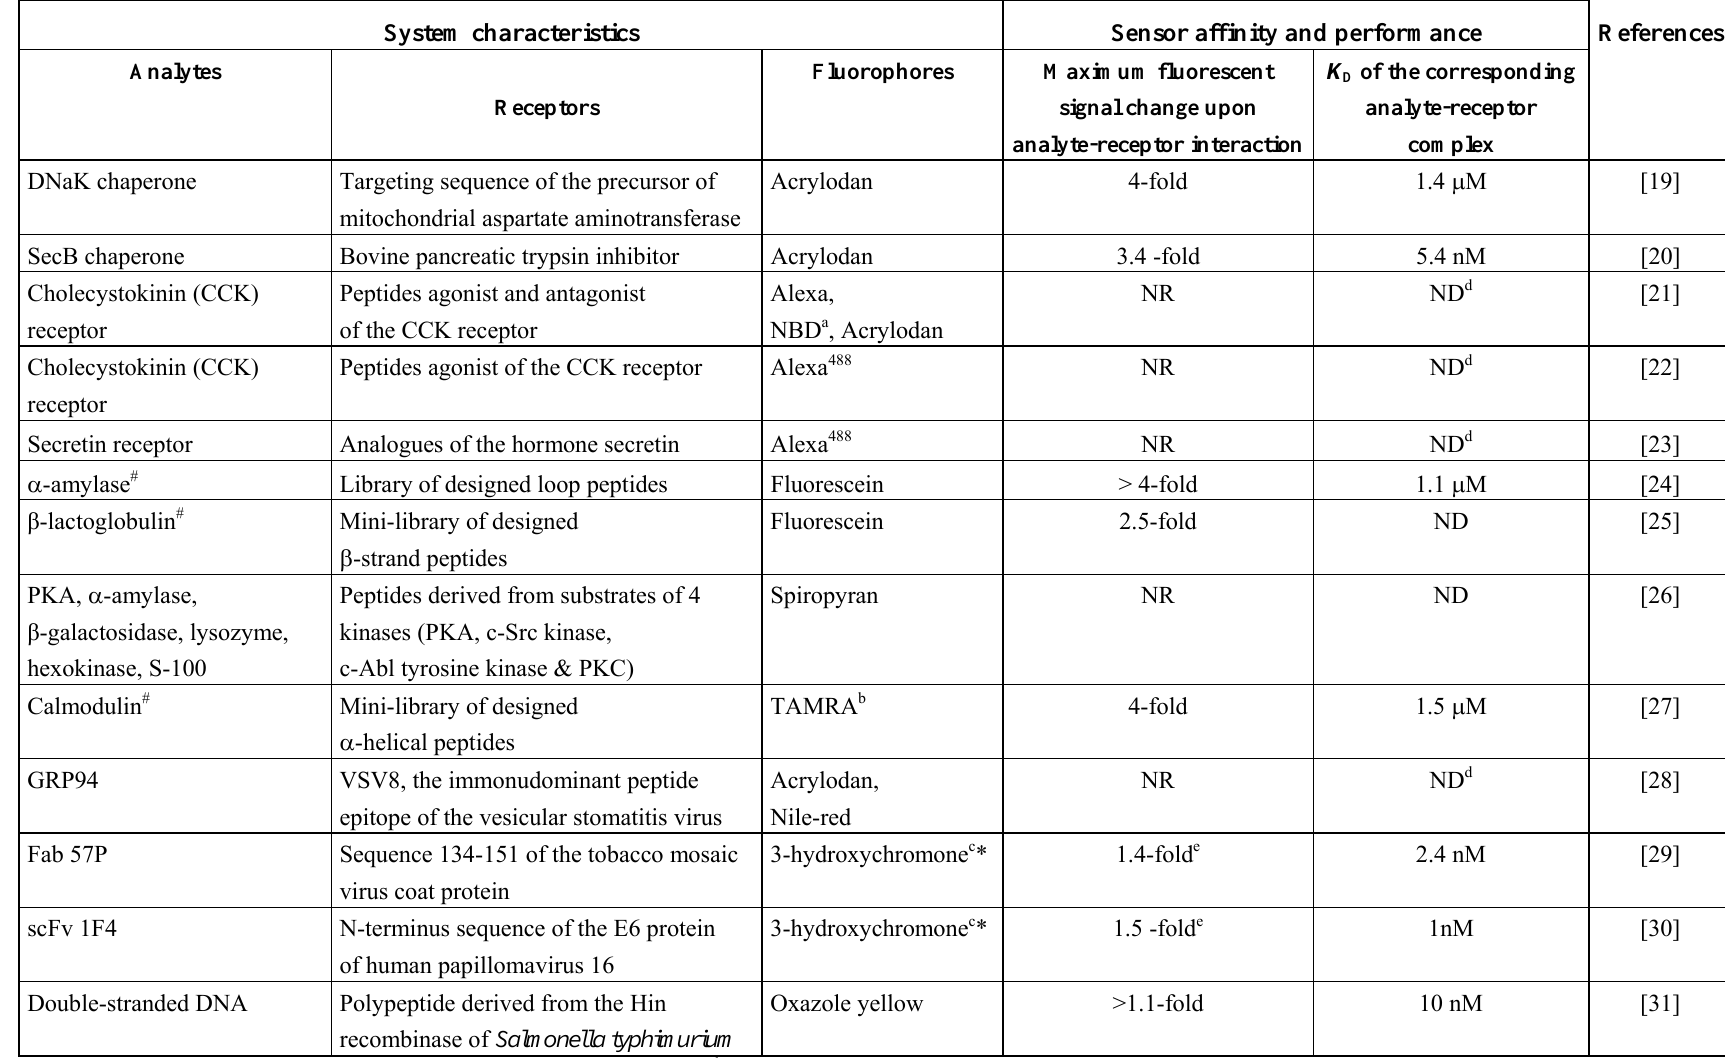
Table 1. Environmentally sensitive fluorescent peptide biosensors constructed by labeling of an amino